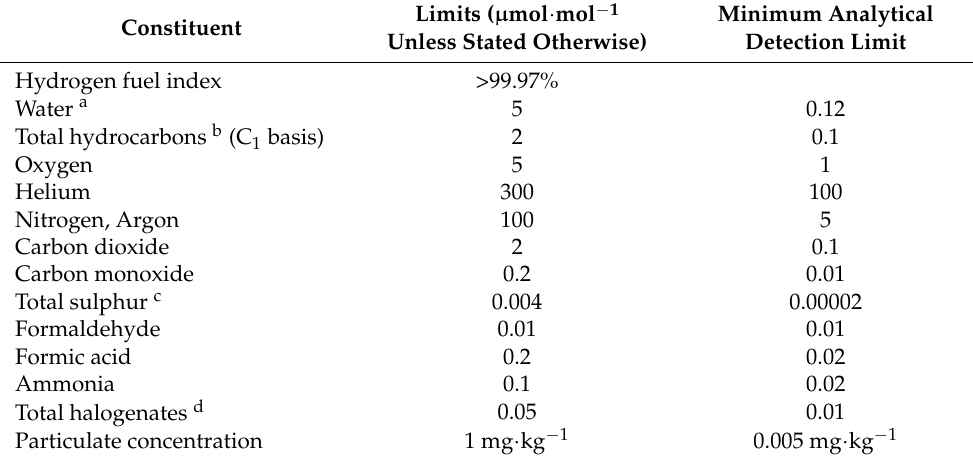
Table 2. Hydrogen fuel quality